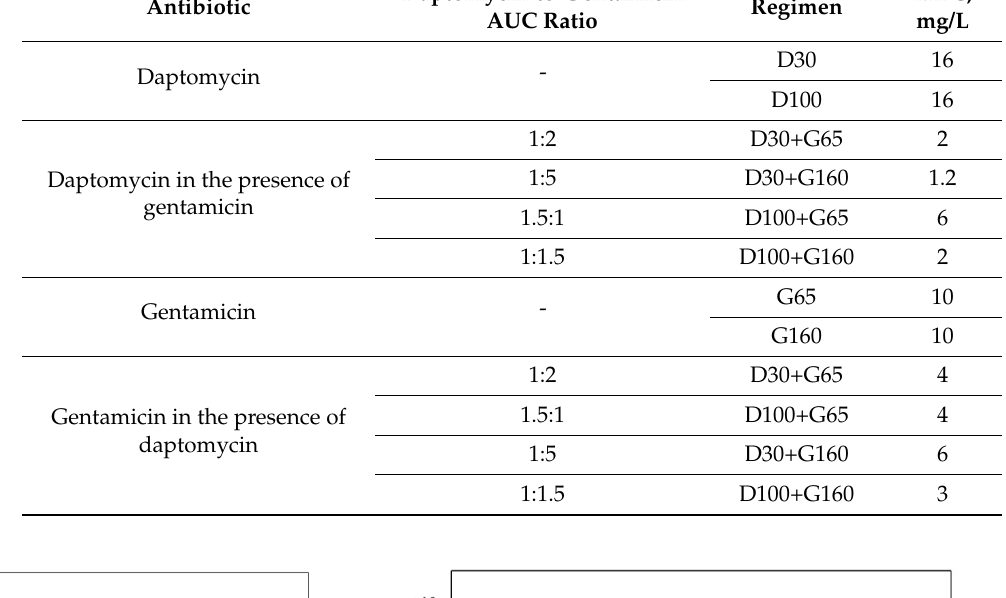
Table 1. MPCs (modal MPC estimation for a data set, n = 3) of daptomycin and gentamicin alone or in combination against Staphylococcus aureus 293. Measured MPC from each replicate was within one doubling of the modal MPC estimate.